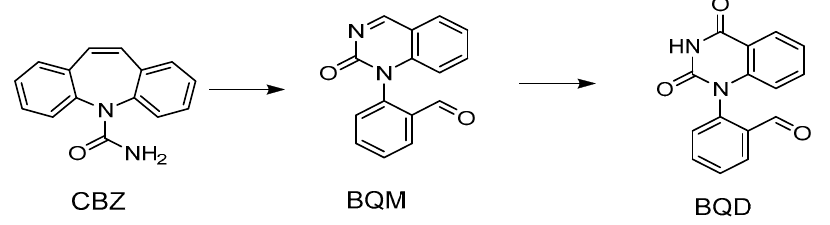
Figure 6. CBZ and its main ozonation products.